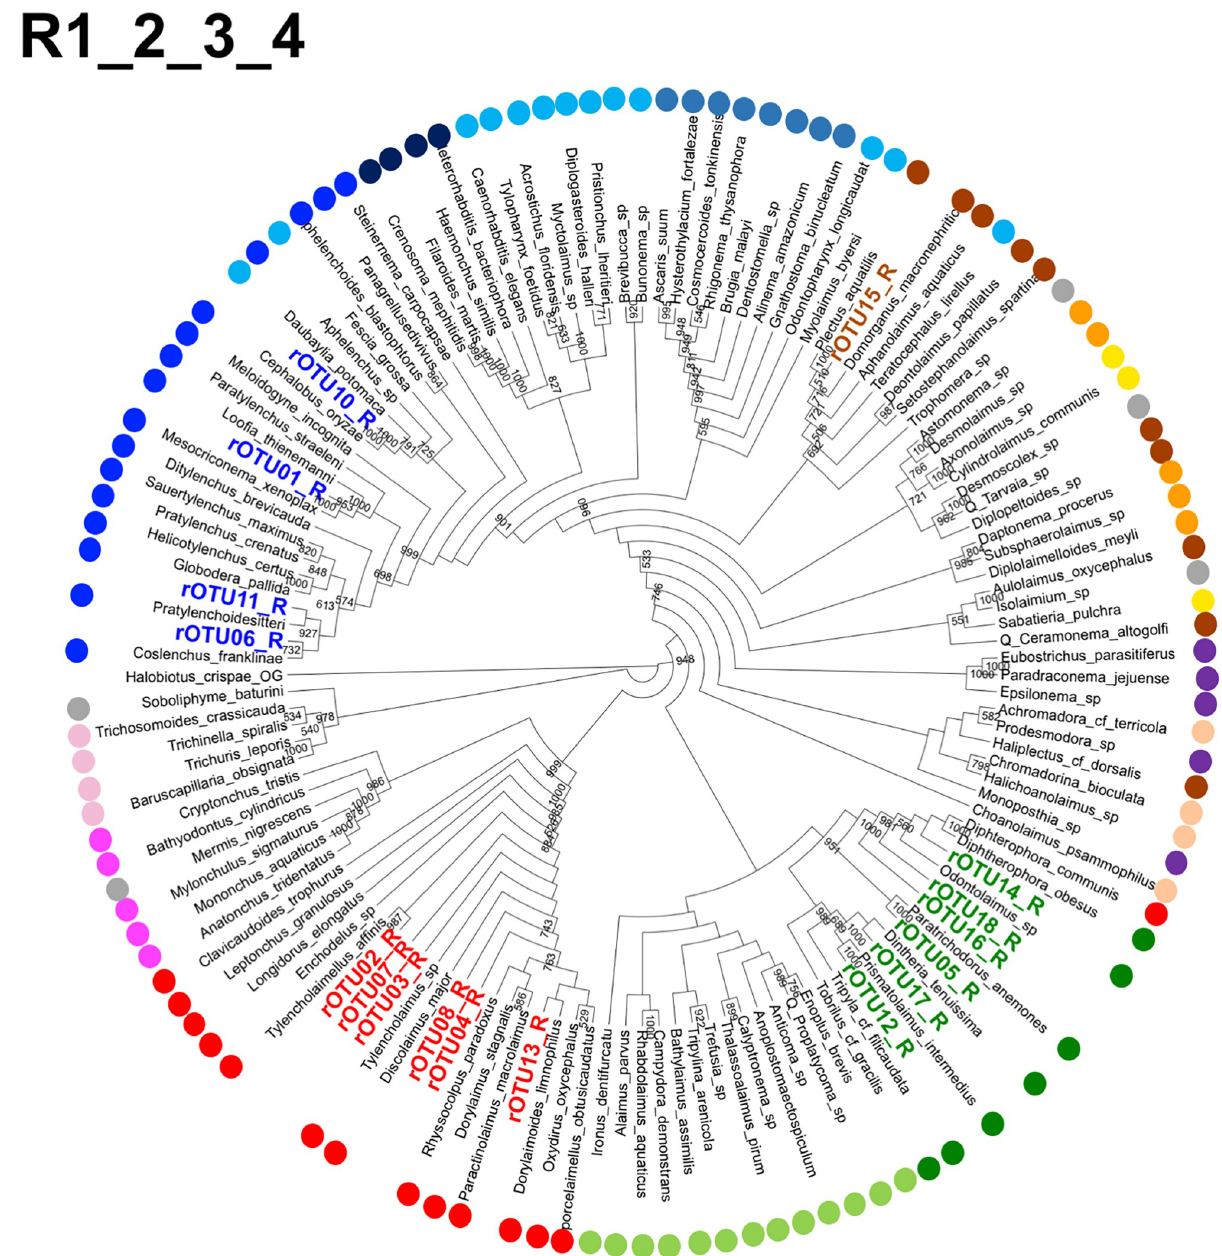
Fig 9. A cladogram of phylogenetic tree generated by combined SSU nucleotide sequences from reference nematode species and rOTUs. The phylogenetic tree was prepared using regional sequences of the reference nematode species and the regional rOTUs corresponding to the combined sequences of the four regions in numerical order (R1_2_3_4), as described in Materials and methods. Orders of the reference species are indicated by colored dots, as shown in the legend for Fig 5.